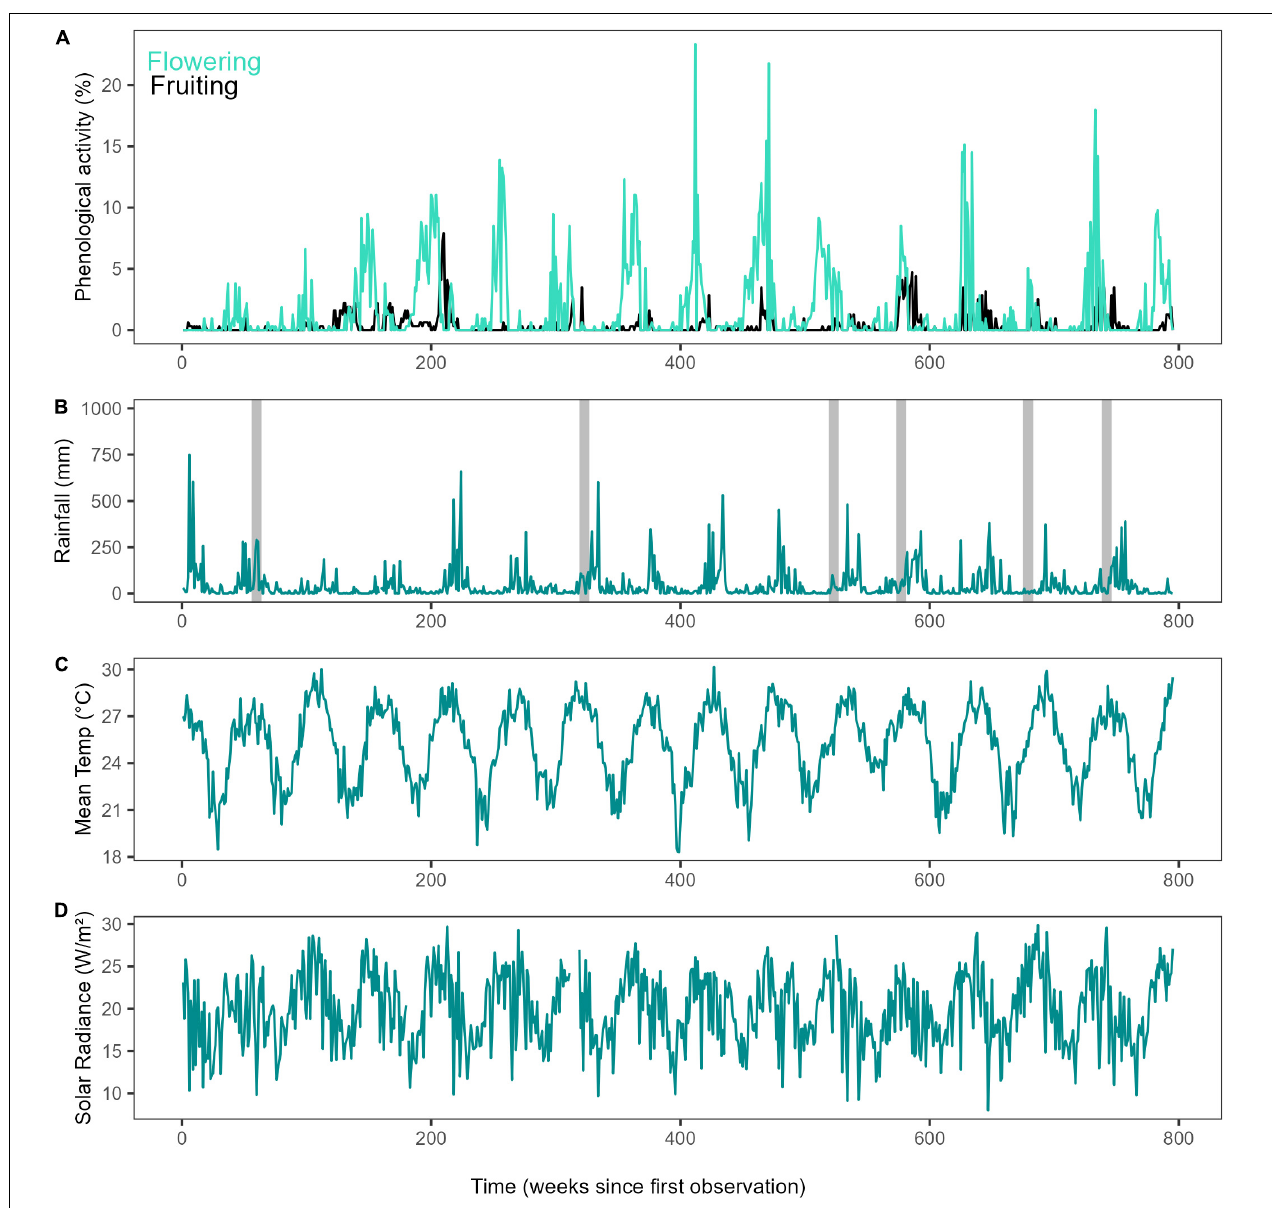
FIGURE 2 | Time series of long-term phenology and climate. (A) Weekly proportion of plots with flowering and fruiting activity for the studied period (2000–2014) in Barron Gorge National Park, Far North Queensland, Australia, (B) Time series for weekly rainfall (mm) and cyclones (grey bars), (C) Mean daily temperature ( ◦ C), and (D) Mean daily solar irradiance (W/m 2